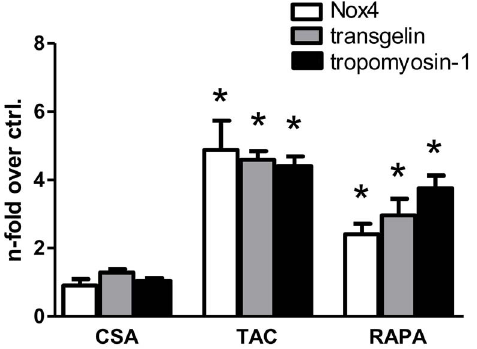
Figure 5. Comparison of the immunosuppressants cyclospor- ine A, tacrolimus, and rapamycin. Both tacrolimus (TAC; 100 nM) and rapamycin (RAPA, 100 nM) induced mRNA for Nox4, transgelin, and tropomyosin-1 after three days, although with a slightly different pattern. Cyclosporine A (CSA; 1 m M) had no effect on mRNA levels. All values normalized to untreated control. (*) denotes significance from untreated cells p # 0,05.